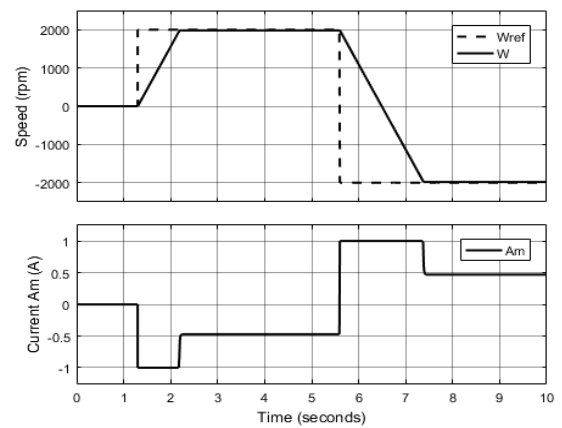
Figure 16. Speed and current when the motor has load.